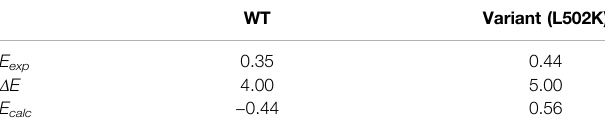
TABLE 2 | Redox potentials of the active site (the unit is